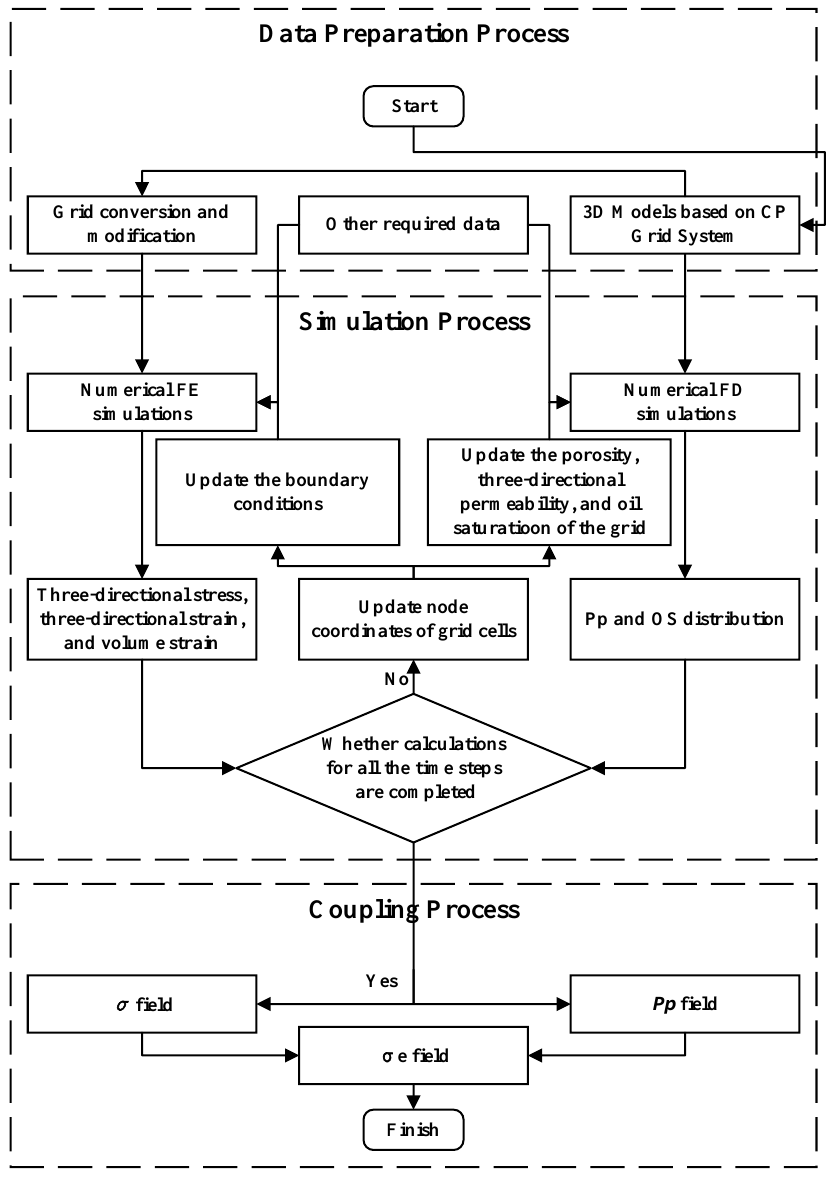
Figure 2. Method for modeling a dynamic σ e field through reservoir – geomechanics coupling. To start the simulations, the 3D models based on CP grid system are first imported. other data required are also imported. Here the data preparation process is